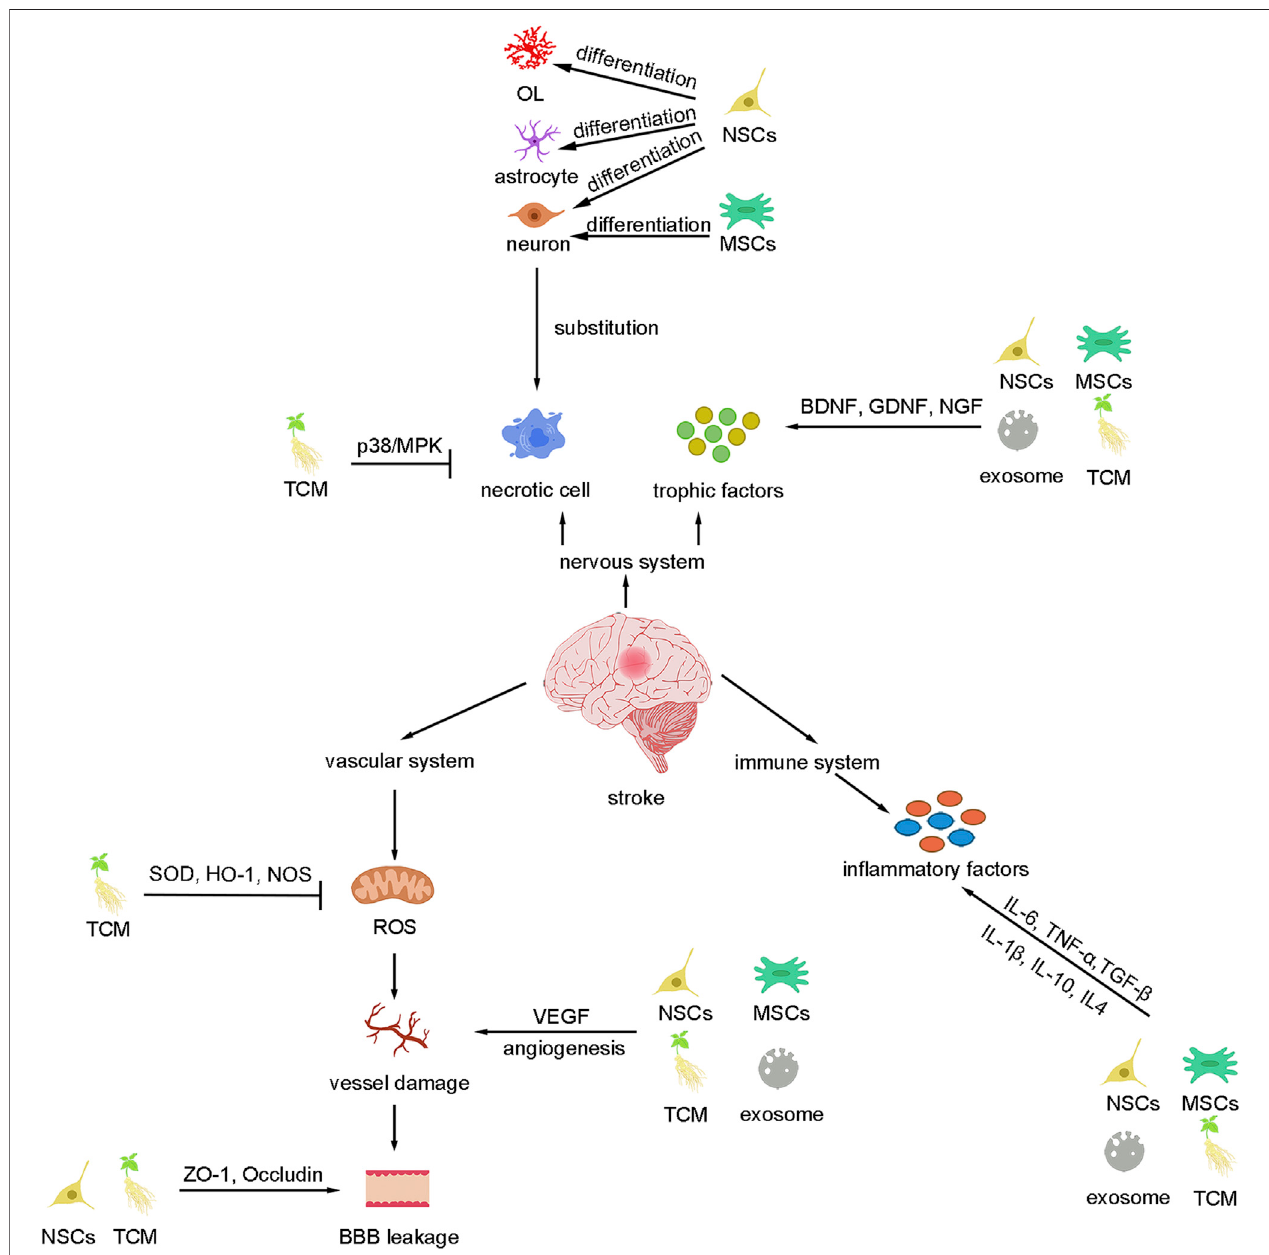
FIGURE 2 | Summary of basic mechanisms underlying different therapies for stroke. These therapies can inhibit cell death and replace the necrotic cells as well as secret trophic factors to improve the nervous system. Besides, these therapies protect the vascular system by inhibiting ROS, BBB leakage, angiogenesis, and in fl